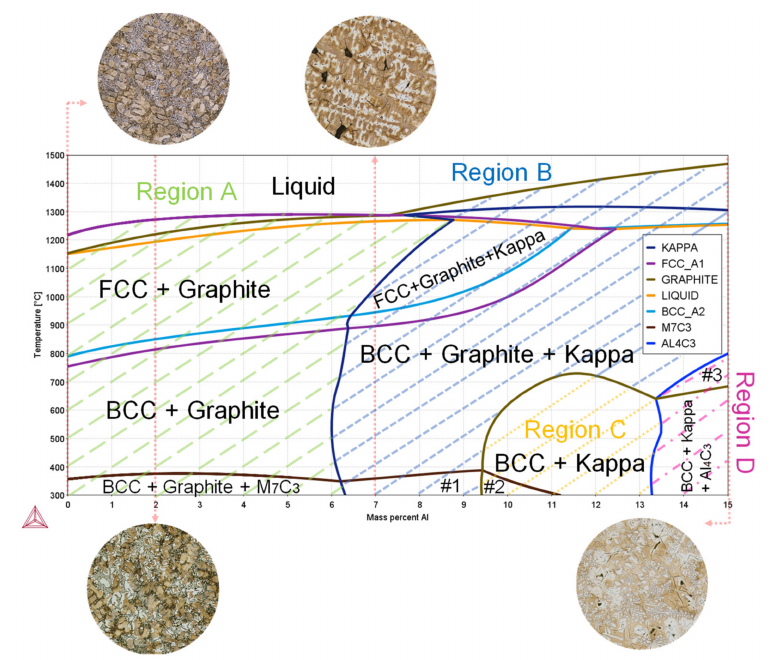
Figure 1. Phase diagram of the nominal composition of the Fe-3.1C-2.0Si-0.6Mn alloy with variable wt.% of Al correlated with the etched microstructures subsequently observed by OM (#1 = BCC + Graphite + kappa + M 7 C 3 ; #2 = BCC + kappa + M 7 C 3 ; #3 = BCC + kappa + M 7 C 3 + Al 4 C 3 ).